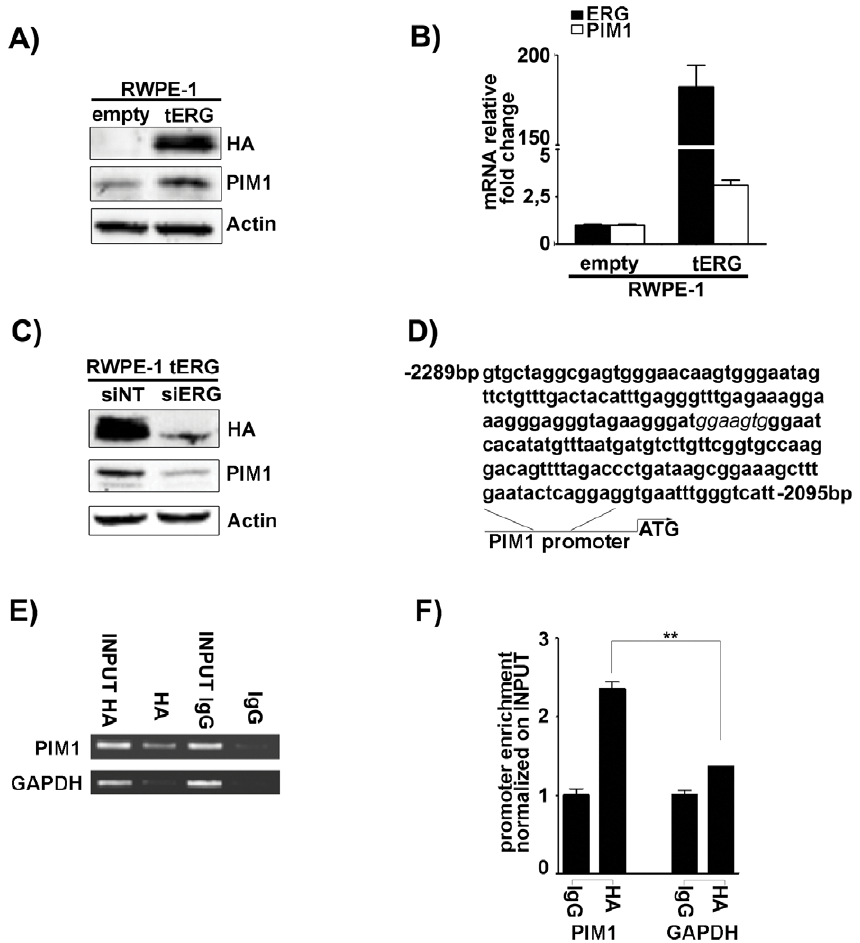
Figure 3. ERG dependent PIM1 induction in RWPE-1 cells. a–b ) PIM1 over-expression in RWPE-1 transfected with HA-tagged TMPRSS2/ERG coding region (RWPE-1_tERG) as evidenced by immunoblot ( a ) and Real-Time quantitative PCR ( b ). Actin is shown as a loading control. ERG and